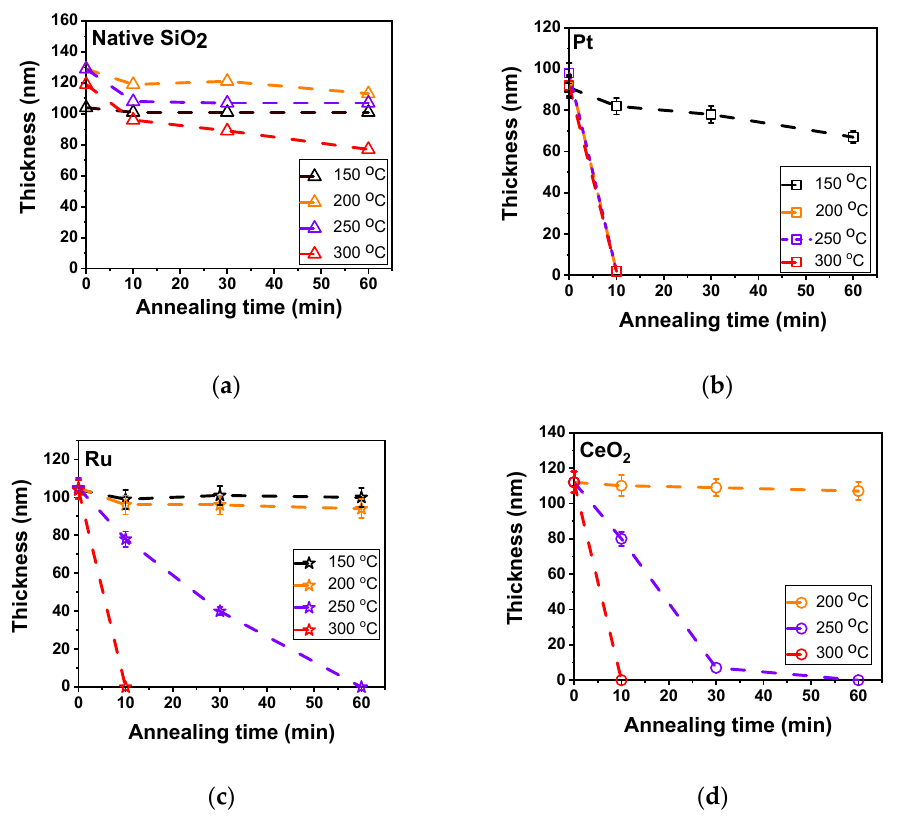
Figure 4. PMMA film thicknesses on different surfaces versus annealing time in air ( a ) Native SiO 2 ; ( b ) Pt; ( c ) Ru; ( d ) CeO 2 .